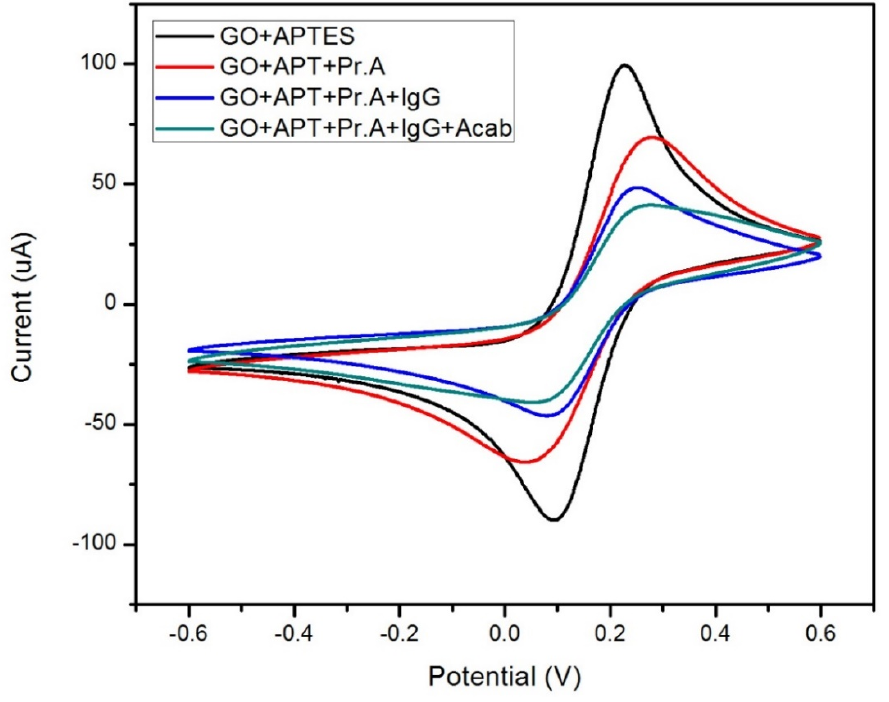
Figure 4. Electrochemical current responses from cyclic voltammetry testing based on additional functionalization layers and groups to the biosensor’s working electrode. A potential range of ±0.6 V was used with K 4 FeCN 6 in PBS as the redox moiety at a scan rate of 50 mV/s.